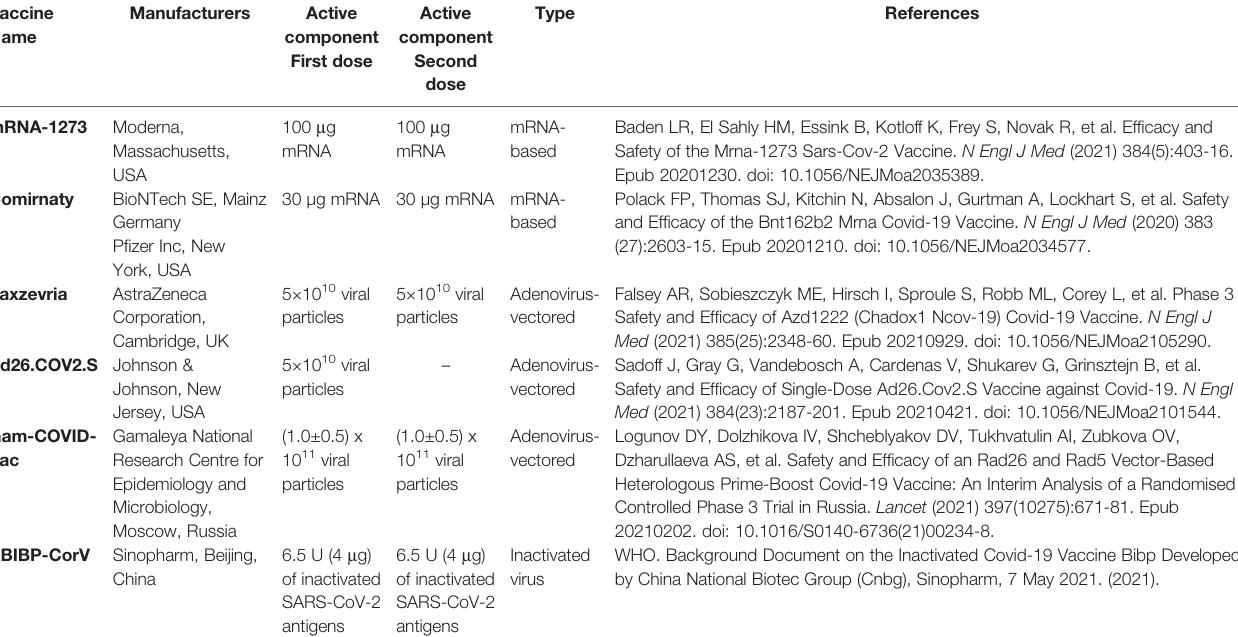
TABLE 2 | Characteristics of investigated